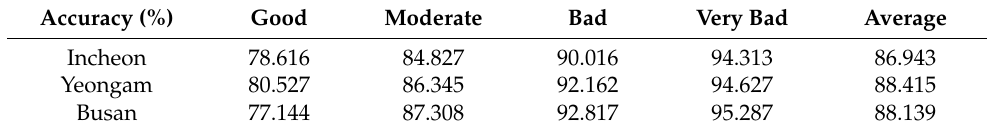
Table 6. The results of particulate matter movement verification by wind